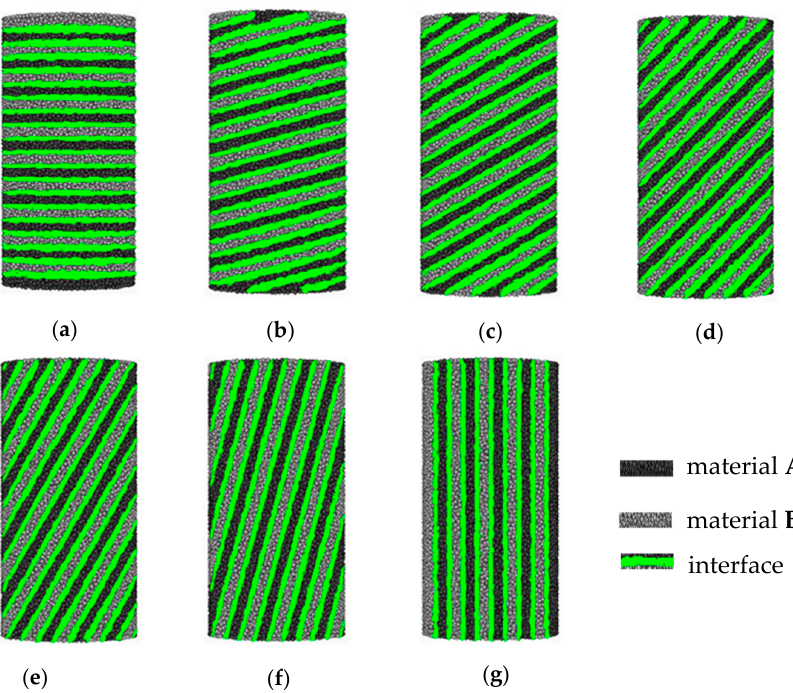
Figure 3. Numerically developed transversely isotropic rock samples having different interface dip angles: ( a ) α = 0°, ( b ) α = 15°, ( c ) α = 30°, ( d ) α = 45°, ( e ) α = 60°, ( f ) α = 75°, and ( g ) α = 90°.